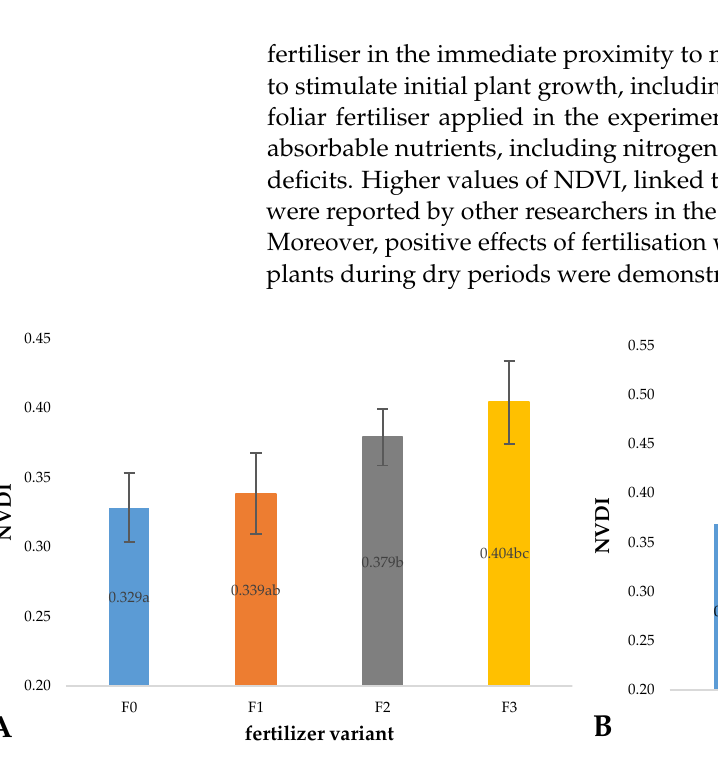
Figure 6. Normalized Difference Vegetation Index (NDVI) recorded August 31 ( A ) and September 11 ( B ). Note: F0—control; F1—foliar fertilization; F2—localized fertilization: microgranules for precision application into the soil; F3—localized fertilization: microgranules for precision application into the soil with foliar fertilization. Differences in the results between Normalized Difference Vegetation Index for fertilization variant are marked with different small letters, p < 0.05.